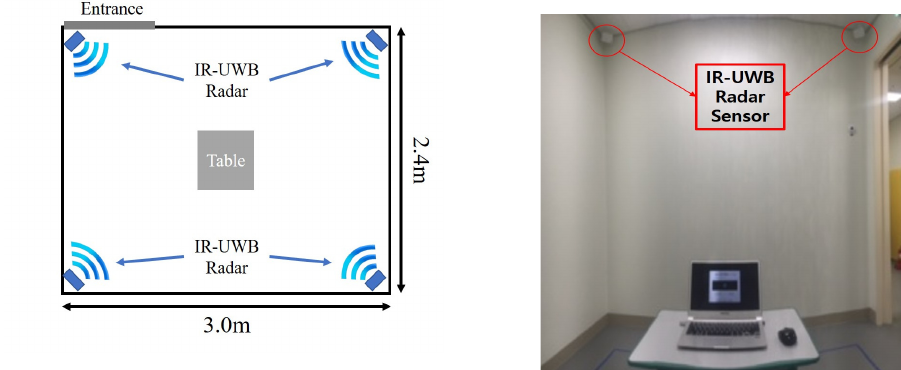
Figure 2. Experimental